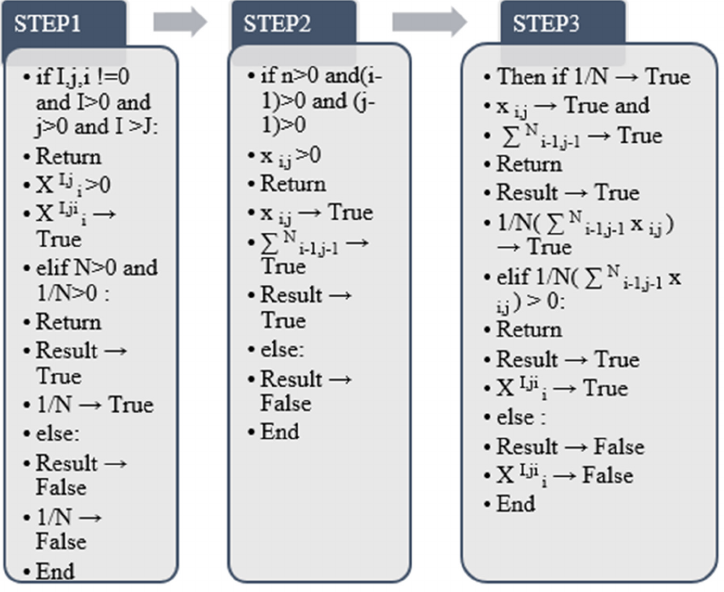
Figure 9. Feature extraction algorithm for 2D convolution (pooling layer).